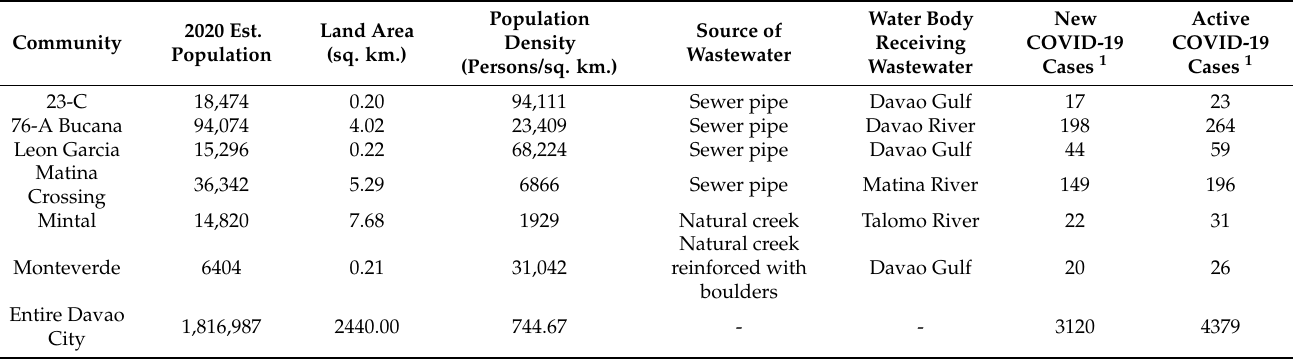
Table 1. Community and sampling site